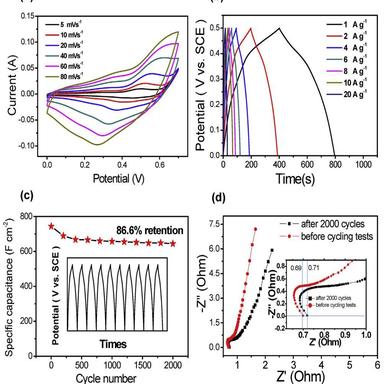
Electrochemical characterizations of MgCo2O4 nanoneedle arrays/Ni foam. (a) Cyclic voltammetry (CV) curves with different scan rates from 5 to 80 mVs1 . (b) Galvanostatic charge-discharge (GCD) curves with different current densities from 1 to 20 A g1 . (c) Cycling test curves at a constant current density of 6 A g1 , the inset is the GCD curves of the typical continuous 10 cycles. (d) Nyquist plots of the MgCo2O4 nanoneedle arrays/Ni foam electrode before and after 2000 cycles at open circuit potential (th